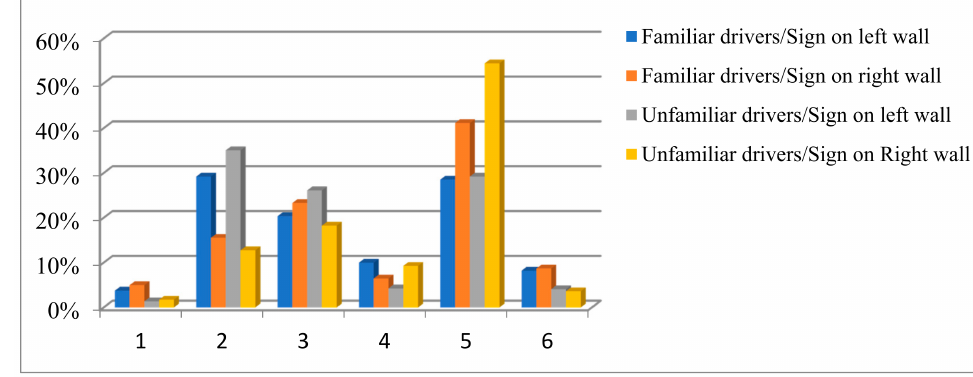
Figure 3. Gaze distributions of drivers with different familiarity